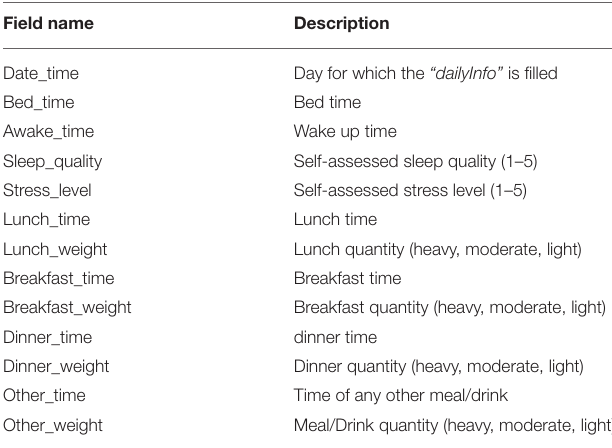
TABLE 5 | Metadata of patient-entered context data “dailyInfo” in JSON file. TABLE 6 | Metadata of patient-entered “event” field in JSON file representing